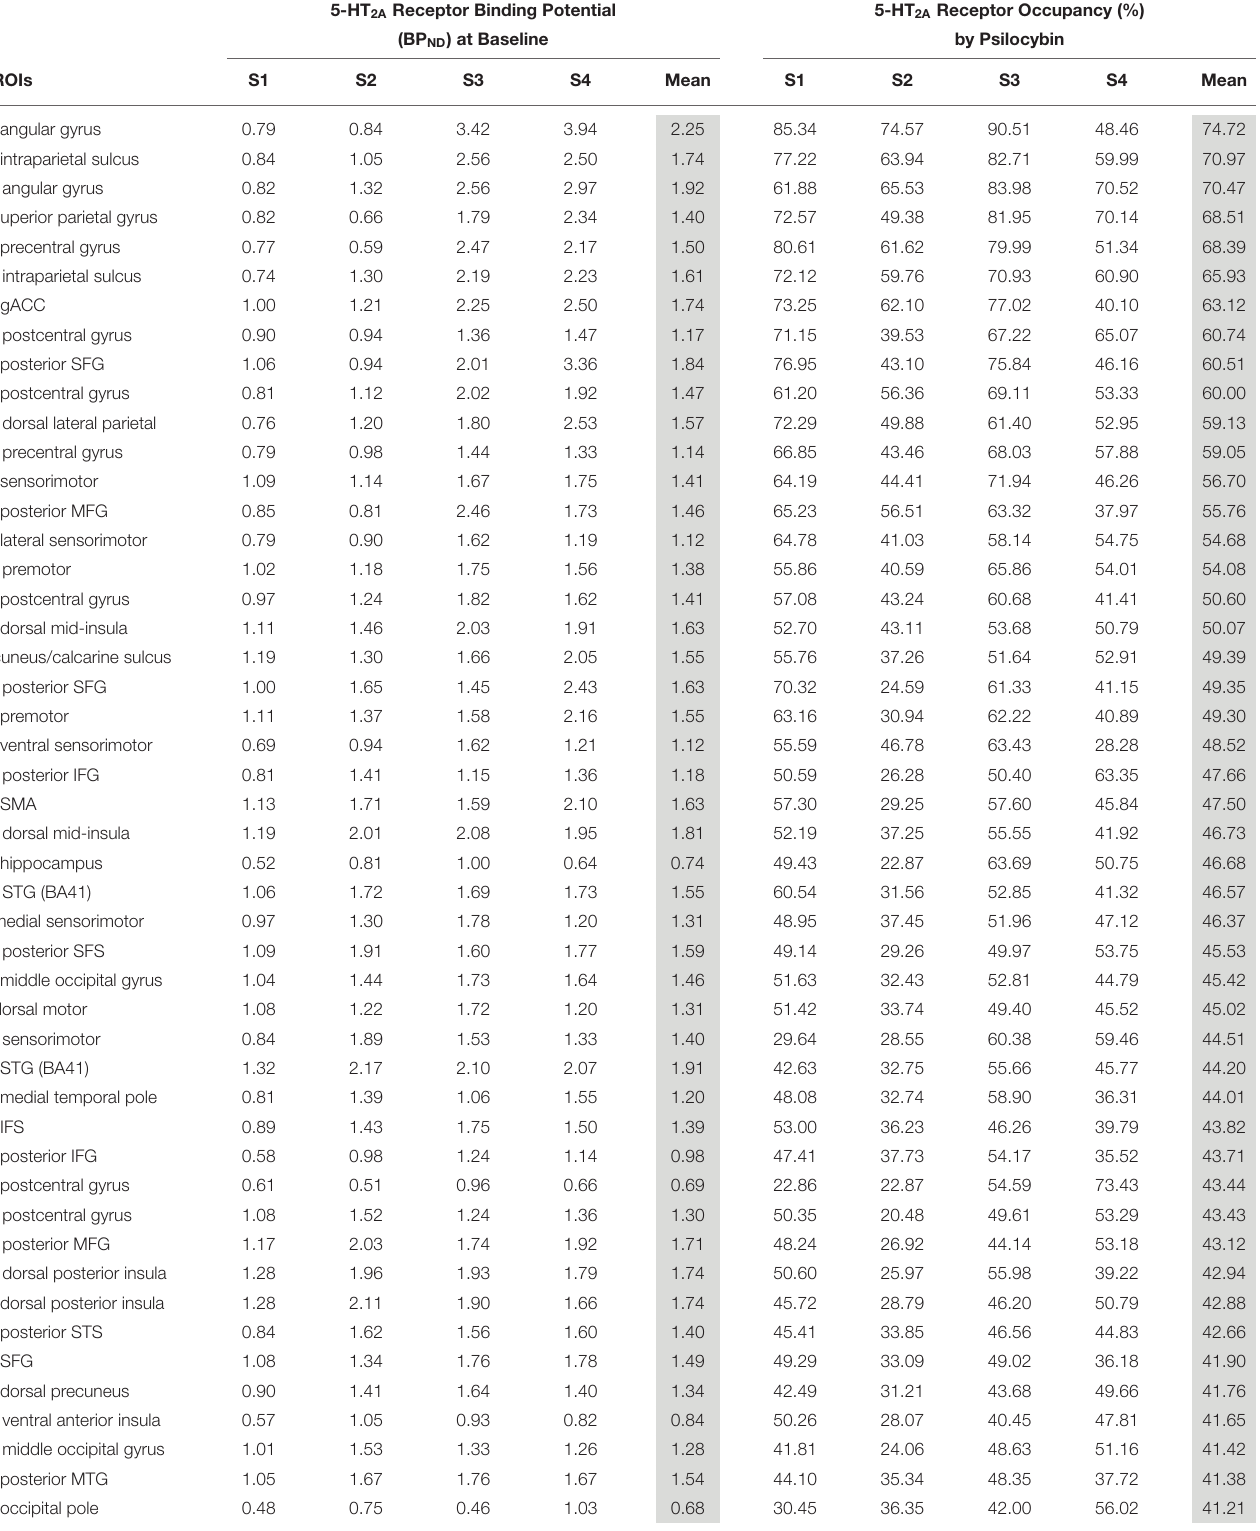
TABLE 1 | Baseline binding potential and occupancy by psilocybin of 5-HT 2A receptors in each region of interest for each subject. 5-HT 2A Receptor Binding Potential 5-HT 2A Receptor Occupancy (%) (BP ND ) at Baseline by